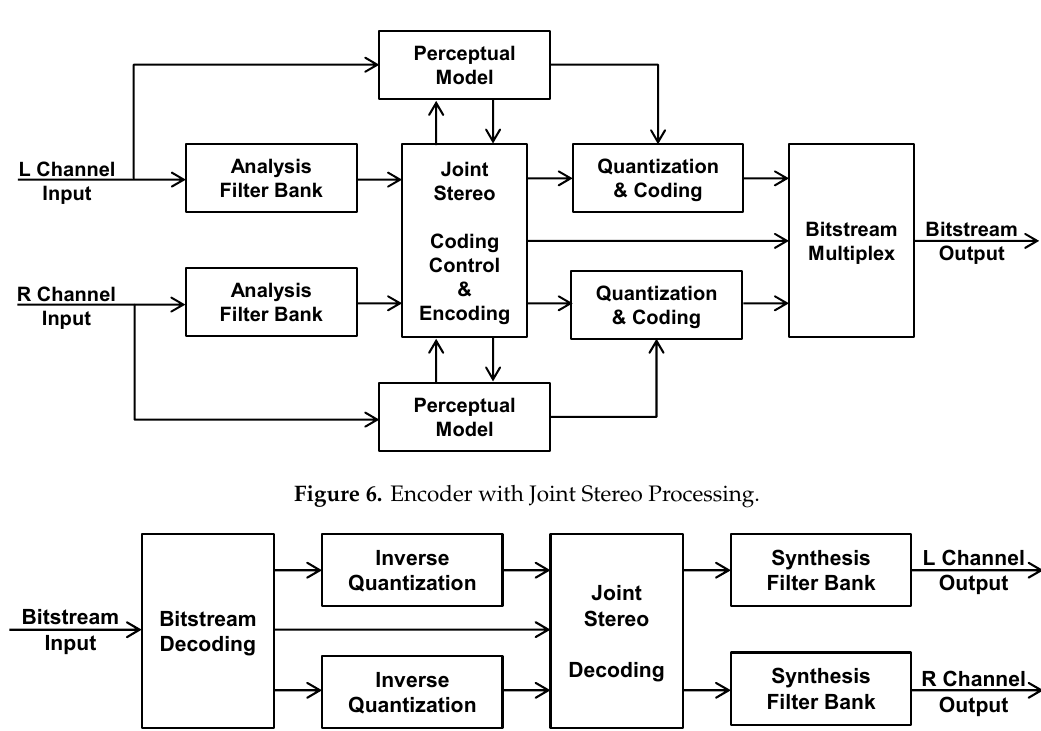
Figure 7. Decoder with Joint Stereo Processing.